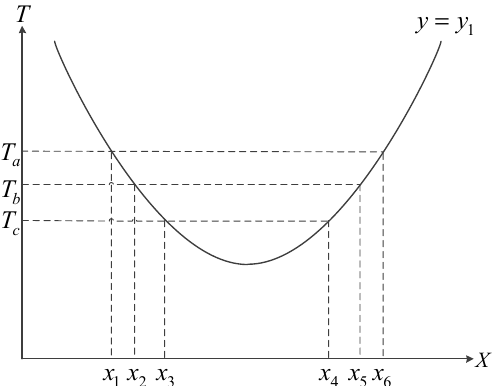
Figure 9. Sampling results along the axial direction in Figure 7.